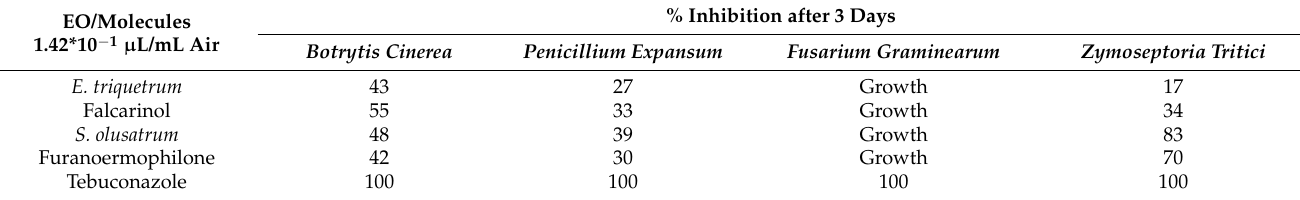
Table 7. Antifungal activity of essential oils and the major compounds on mycelial